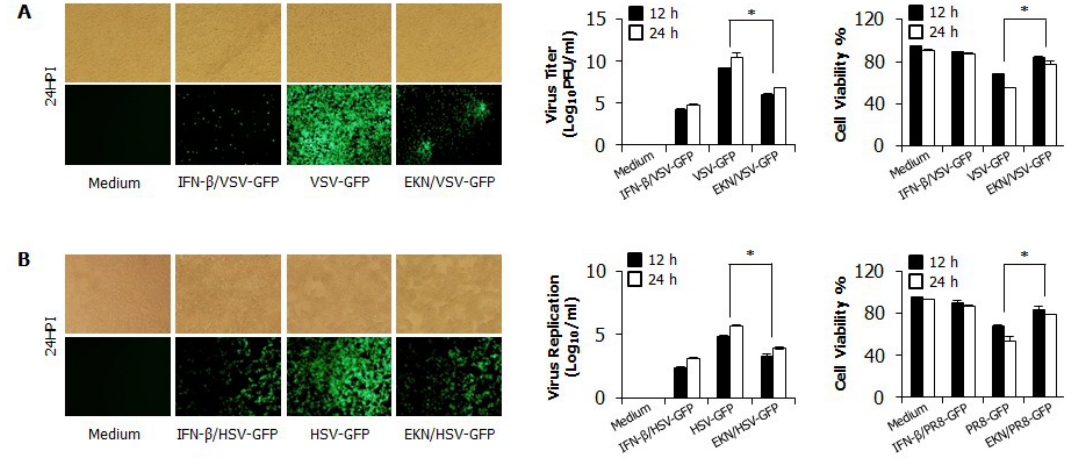
Figure 2. Antiviral activities of Epimedium koreanum Nakai in HEK293T cells. HEK293T cells treated with media alone, 1.0 µg/mL Epimedium koreanum Nakai (EKN), or 1000 unit/mL recombinant human IFN-β, 12 h prior to infection with ( A ) VSV-GFP; or ( B ) HSV-GFP at an MOI of 1.0 and 3.0, respectively. Images were obtained at 24 hpi (200 × magnification). Viruses were titrated from the cultured supernatant and from the infected cells for VSV-GFP and HSV-GFP, respectively. Virus titrations are expressed as mean ± SD. Error bars indicate the range of values obtained from two independent experiments. Cell viabilities were without treatment). Cell viabilities are expressed as mean ± SD. Error bars indicate the